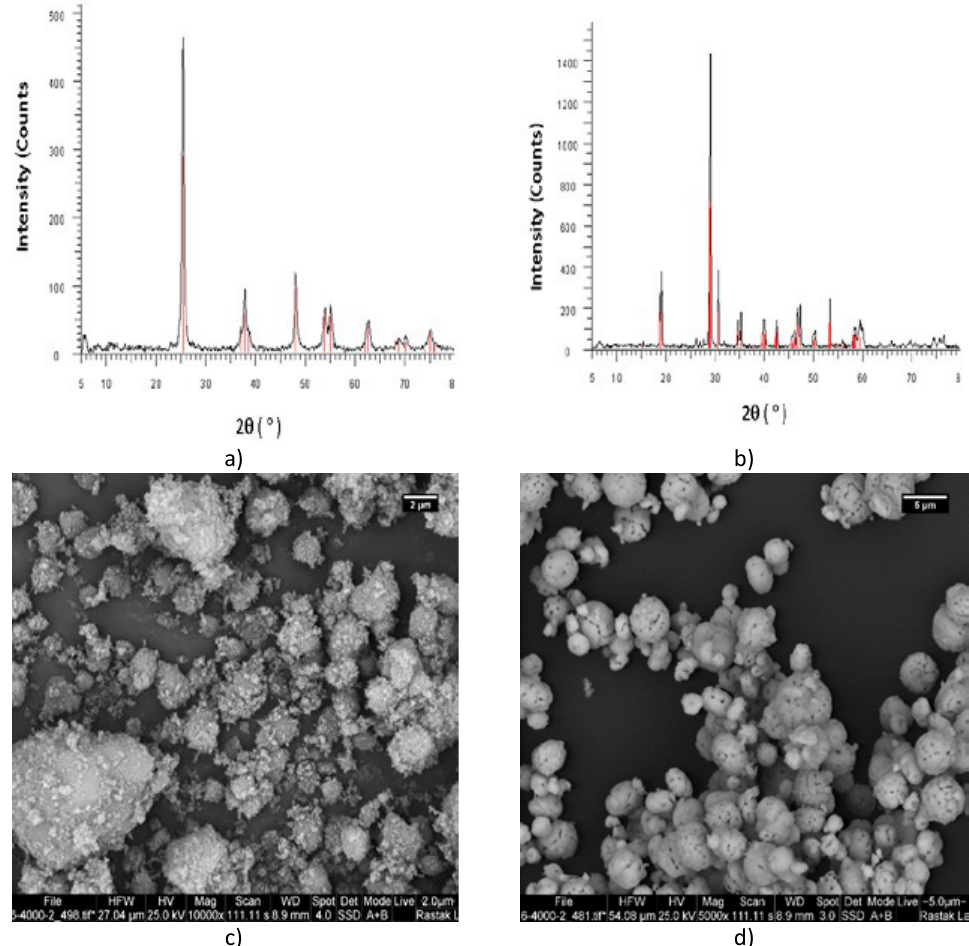
Fig. 4: Characteristics of nano‐photocatalysts: a) XRD pattern of nano‐TiO 2 in the anatase form; b) XRD pattern of the